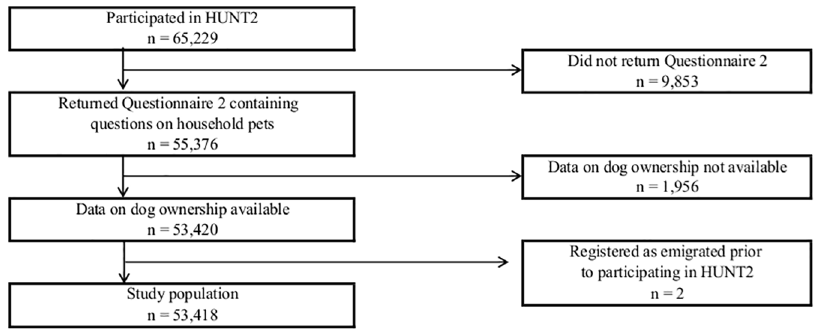
Fig 1. Selection of study participants. The Nord-Tr ø ndelag HUNT Study HUNT2 (1995–1997).